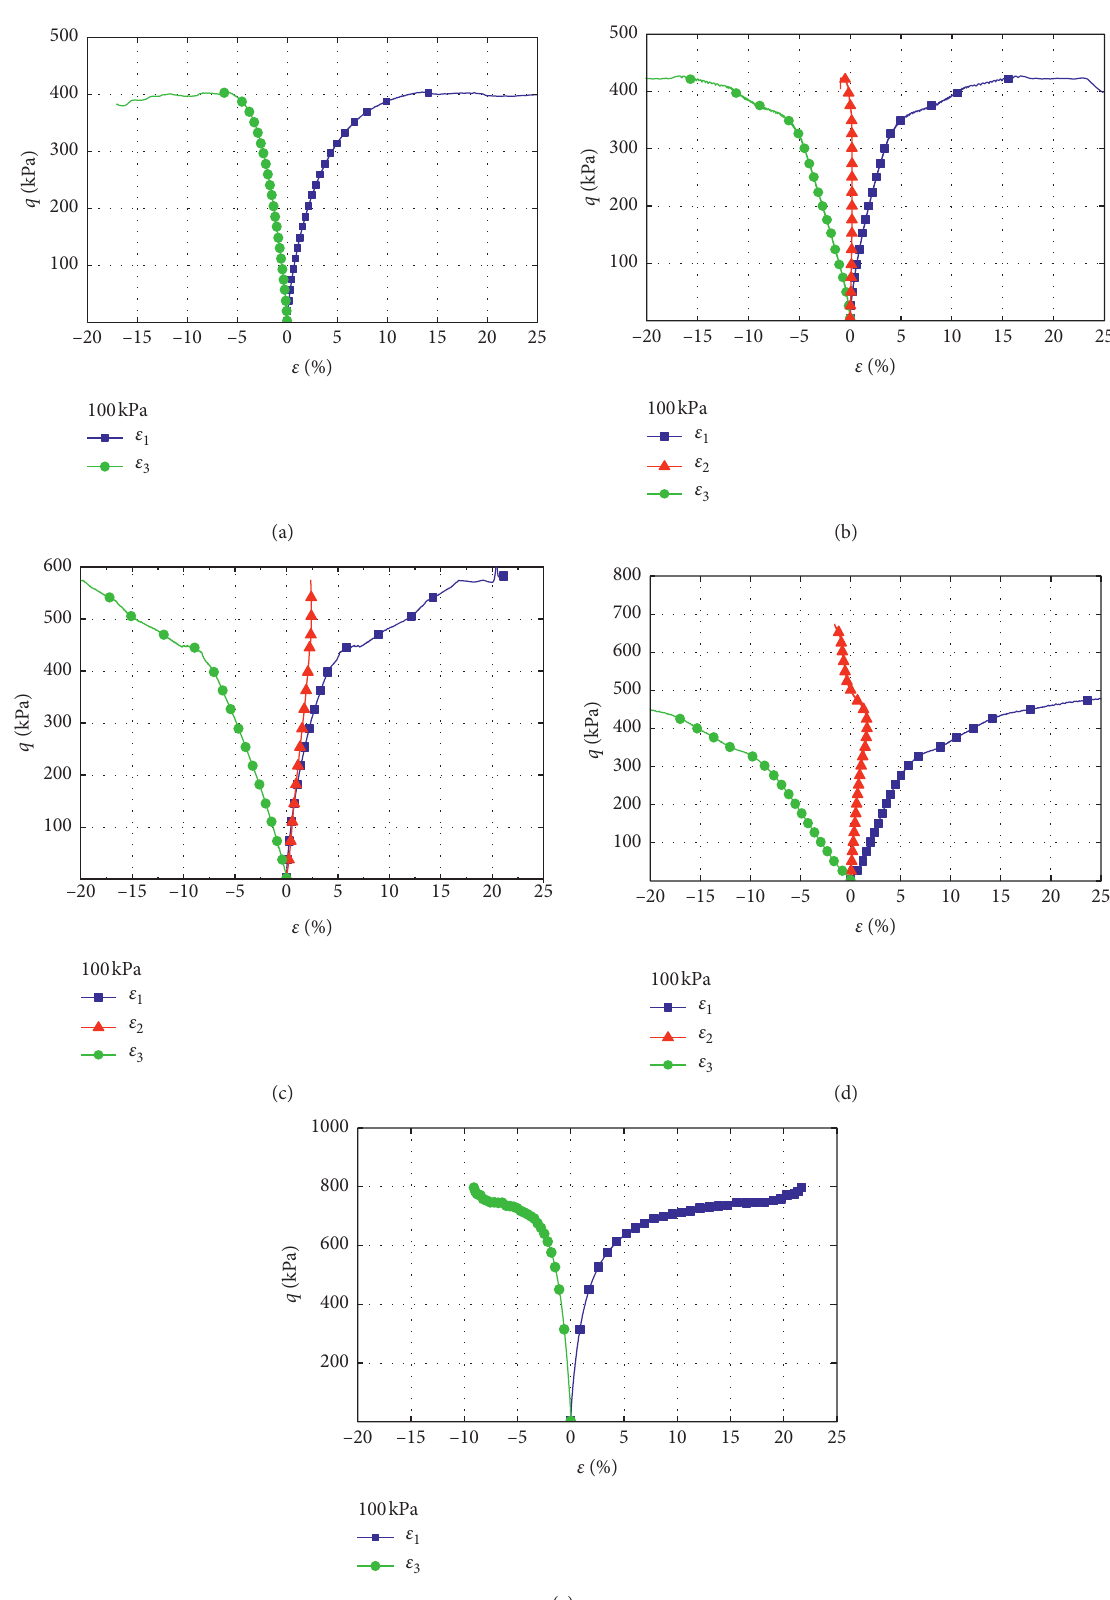
Figure 8: Stress-strain relationships of different b . (a) b � 0. (b) b � 0.25. (c) b � 0.5. (d) b � 0.75. (e) b �